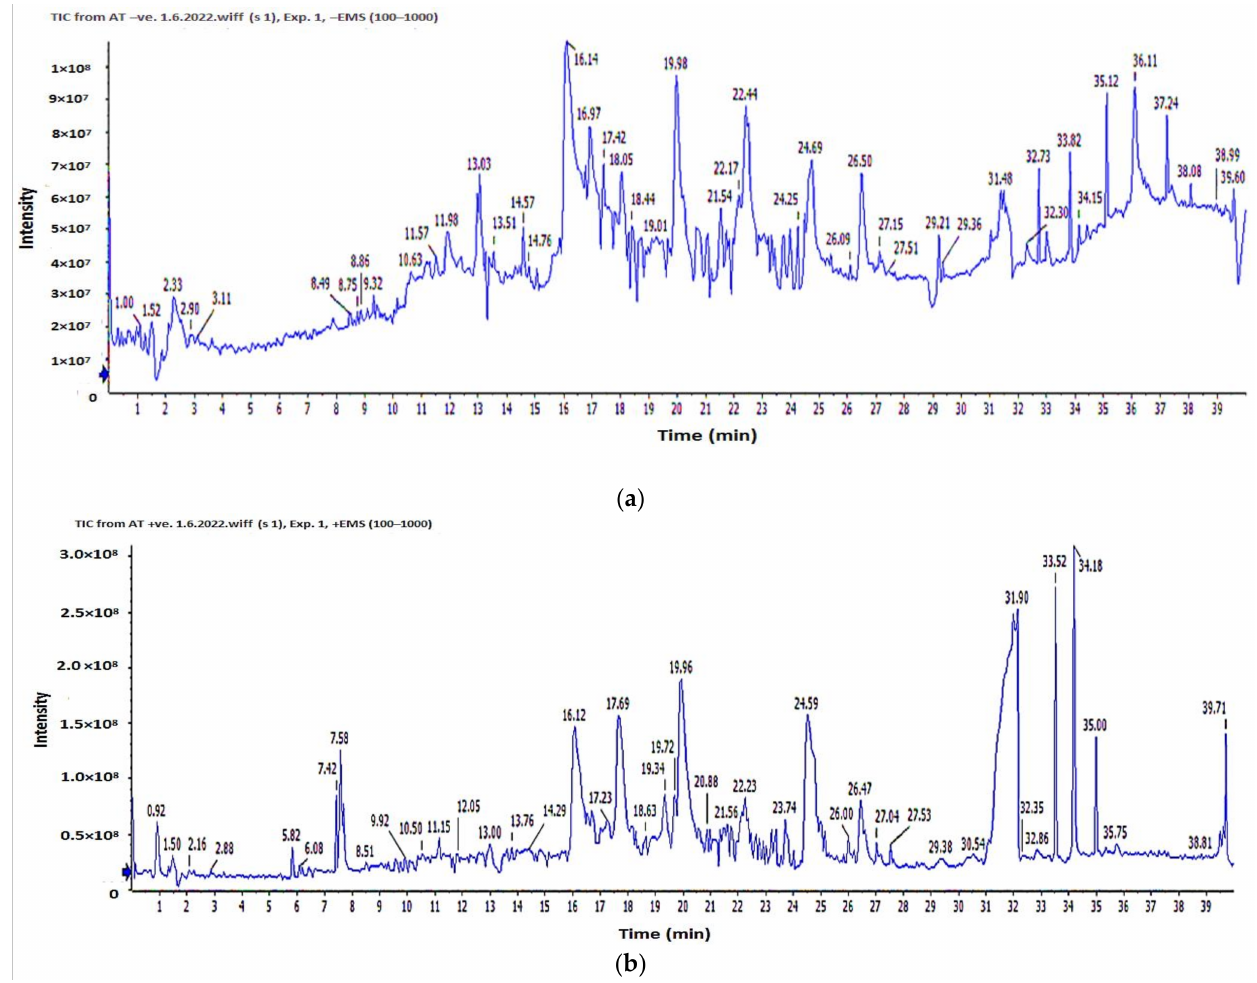
Figure 6. ESI-TIC chromatograms of A. tenuissima ethyl acetate extract: ( a ) negative mode; ( b ) positive